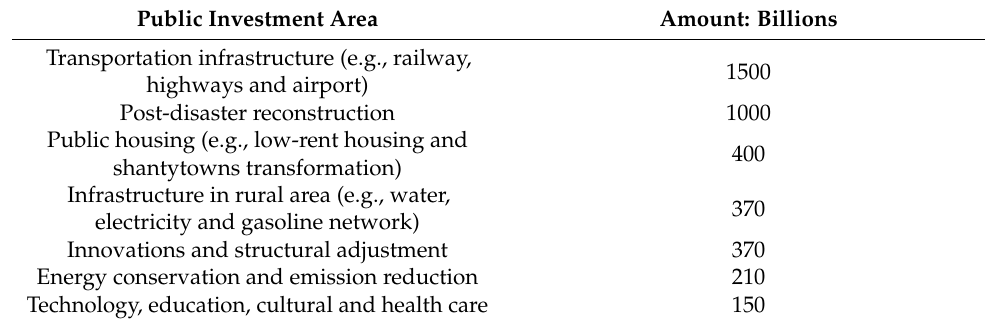
Table 1. The approximate amount and investment areas of the 4 trillion RMB stimulus package from the fourth quarter of 2008 to the end of 2010.